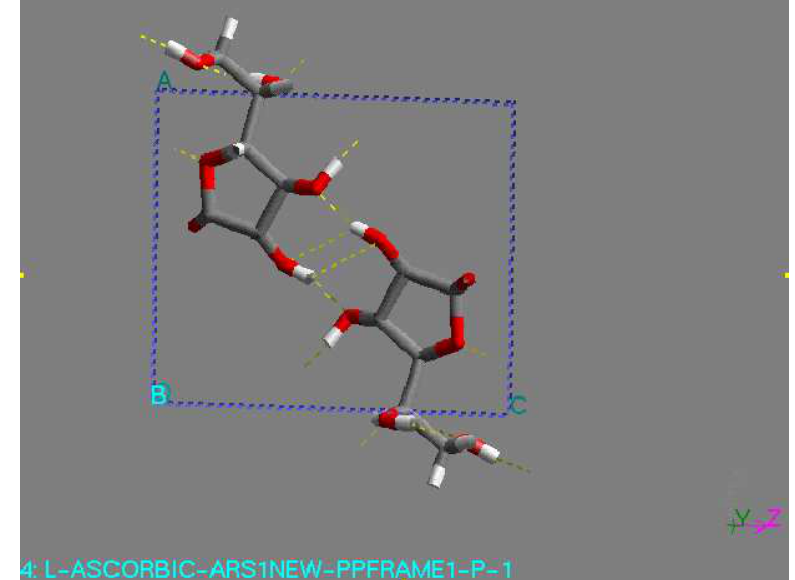
Figure 1. P-1 structure, found by minimization. This structure had the lowest lattice energy in the DREIDING force field. View along the c-axis